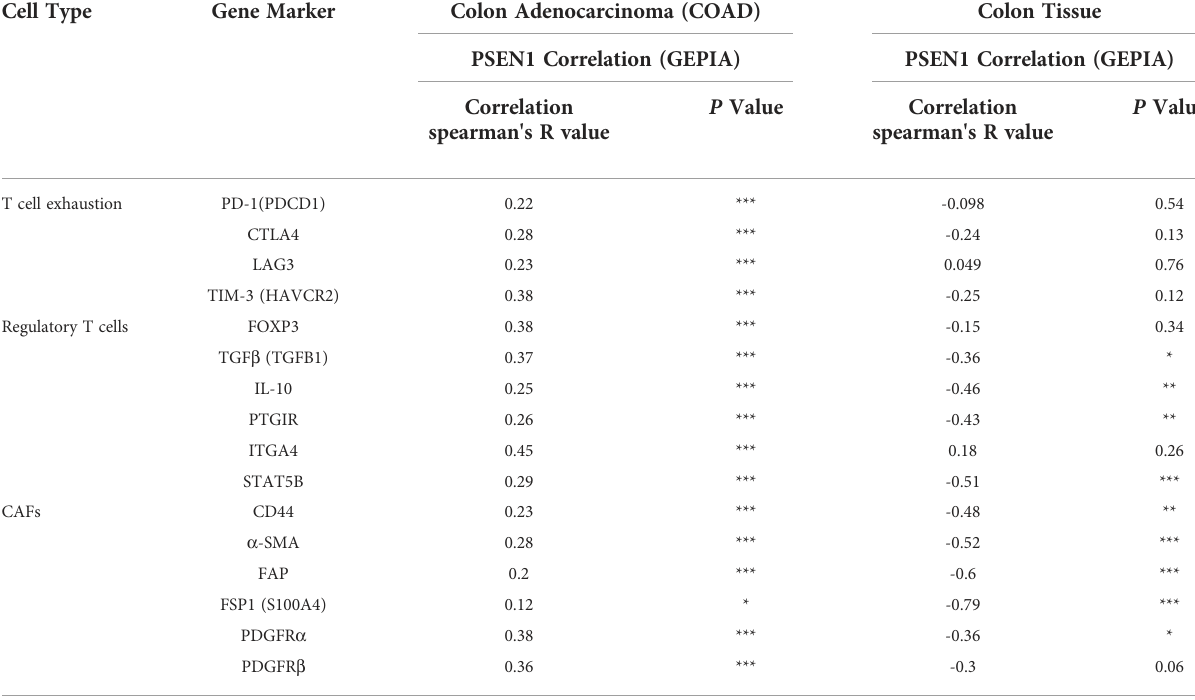
TABLE 4 Correlations between PSEN1 and the Gene Markers of the Immune Subsets determined by